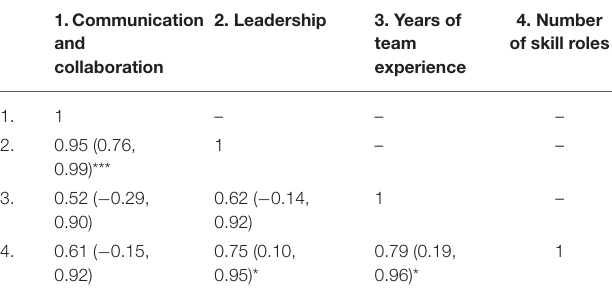
TABLE 1 | Correlations (and 95-percent Confidence Intervals) for the